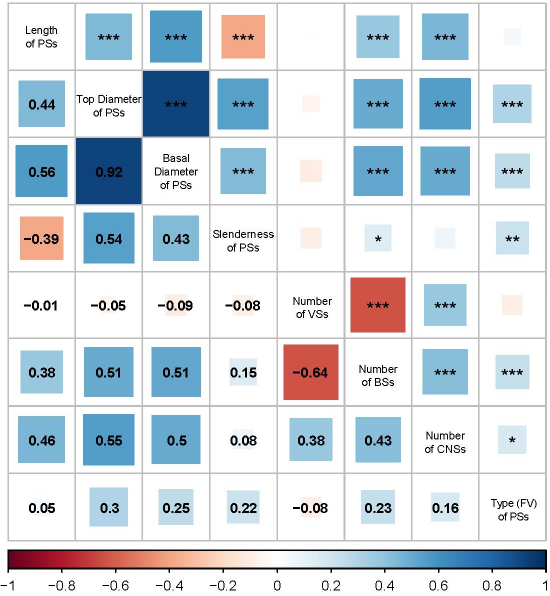
Figure 6. Correlations among the properties of the “Yuanhua” Sapindus mukorossi parent shoots. Note: Length of PS, length of the parent shoot; Top Diameter of PS, the diameter of the tip of the parent shoot; Basal Diameter of PS, the diameter of the base of the parent shoot; Slenderness of PS, the slenderness of the parent shoot; Number of VSs, the number of vegetative shoots on parent shoots; Number of BSs, the number of bearing shoots on parent shoots; Number of CNS, the total number of current-year shoots on parent shoots; Type (FV) of PS, the types of parent shoots. Asterisk in the fi gure are p -values and represent statistical signi fi cance (* p < 0.05, ** p < 0.01, *** p < 0.001). The total yield of a single PS was used as the dependent variable, and the length of the PS, top diameter of the PS, basal diameter of the PS, slenderness of the PS, type (F or V) of the PS, number of BSs, number of VSs, and the number of CNS were used as the independent variables; the sampling year and sampling tree were used as random factors. Using the zero-in fl ated GLMM for the analysis, the model was re fi ned based on the AIC